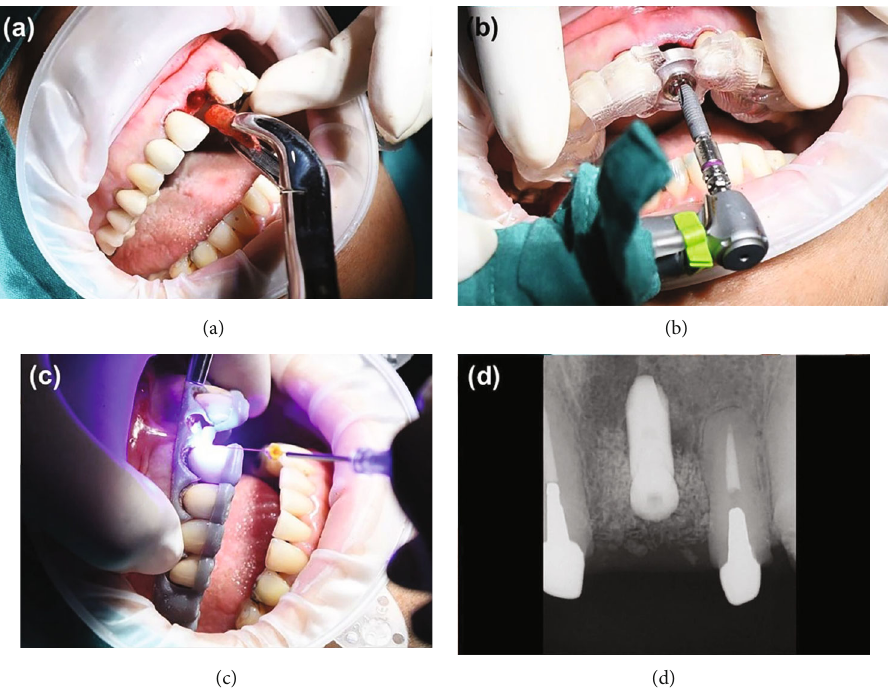
Figure 5: Atraumatic extraction of tooth 21 (a), dental implant placement using a surgical guide (b), crown lengthening by using a laser (SiroLaser Blue Dentsply Sirona, Bensheim, Germany) with digitally assisted crown lengthening guide (c), and periapical radiograph post dental implant placement (d).